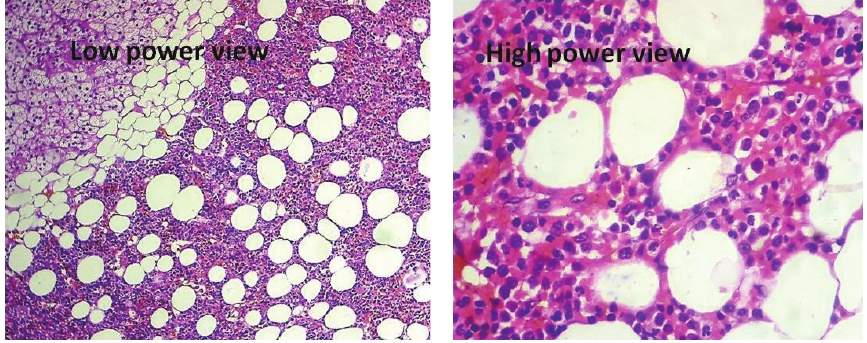
Figure 5: Histopathology of the adrenal myelolipoma—low and high power